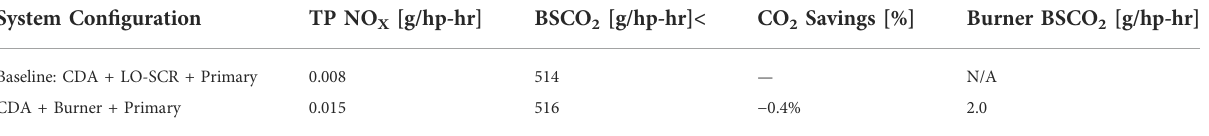
TABLE 7 Hot start HD-FTP results comparison between Baseline and CDA + Burner + Primary system. System Con fi